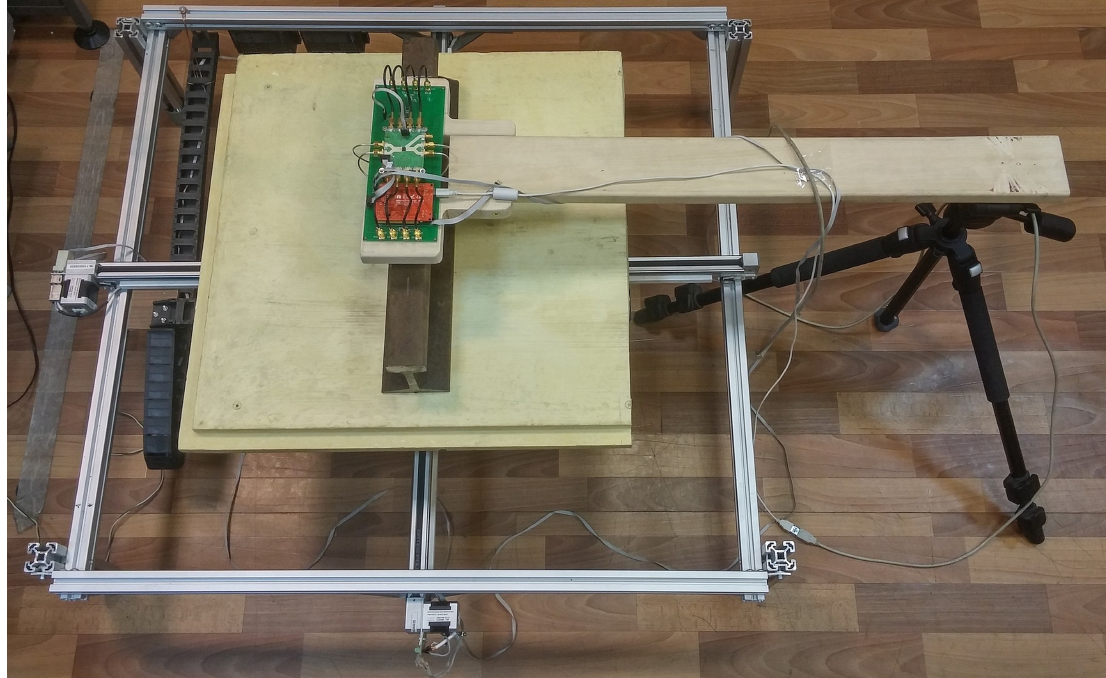
Figure 1. Photo of the experimental setup consisting of two-coordinate mechanical scanner and continuous wave radar with frequency switching.